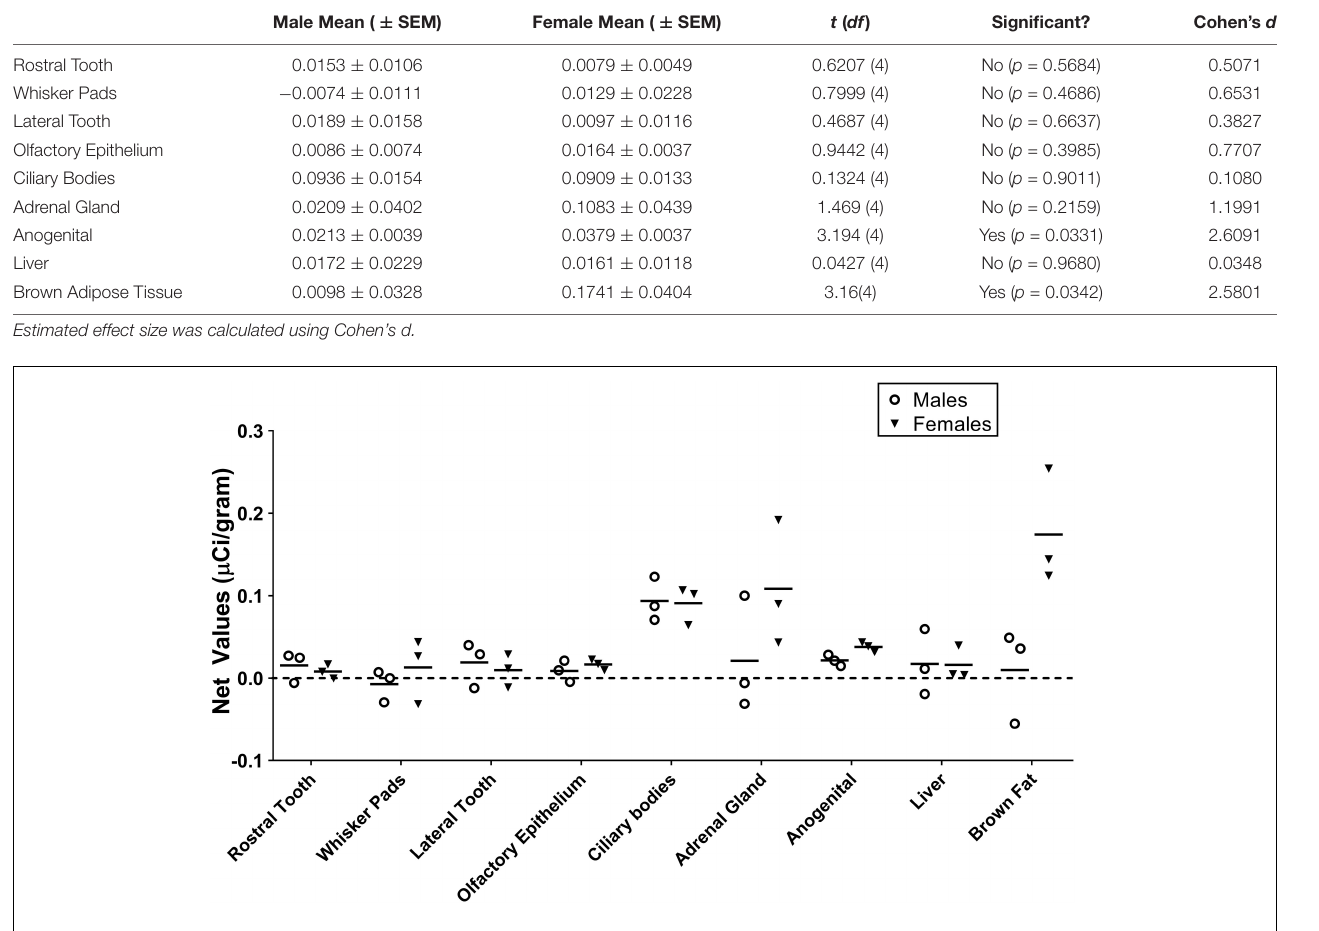
FIGURE 1 | Quantification of receptor autoradiography for net µ Ci/gram OXTR in the peripheral tissue of neonatal Microtus ochrogaster. The net OXTR binding values (net = density of 0–1000 nM) for all regions in prairie voles with specific OXTR ligand binding are compared against a common y -axis. Group means and individual subject data are plotted males (open circles), females (filled